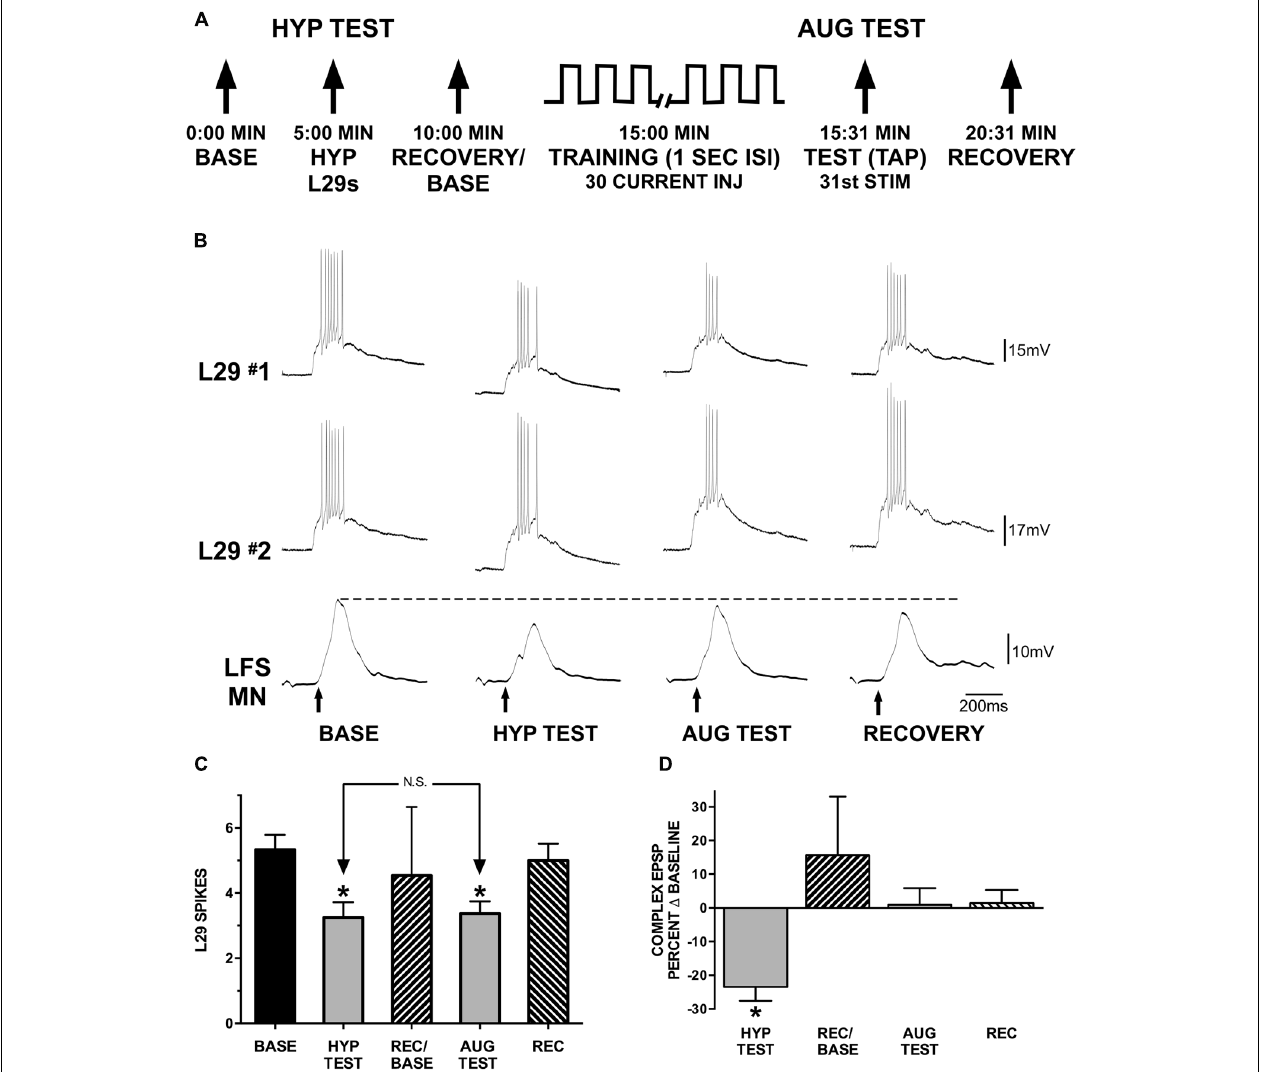
FIGURE 6 |Augmentation compensates for reduced L29 activity. (A) Experimental protocol. In the first part of the experiment (HYP TEST), tap-evoked L29 activity is decreased by injection of hyperpolarizing current into both L29 neurons. In the second part of the experiment, tap-evoked L29 activity is decreased through repeated current injection at a 1 s ISI into both neurons (intrinsic plasticity; see Figure 3 ). Repeated current injection also augments the strength of the L29 to LFS excitatory synapse ( Figure 5 ). (B) Representative physiological traces from a single experiment. All responses are evoked by siphon tap (arrows). LFS MNs are hyperpolarized ≈− 40 mV from rest to reveal the siphon-evoked complex EPSP. The dashed line indicates baseline-level responding. The dashed line indicates baseline-level responding. In the HYP TEST, the response to tap in both of the L29s is reduced by hyperpolarizing them. This results in a reduction of the tap-evoked LFS MN response. In phase 2, L29’s